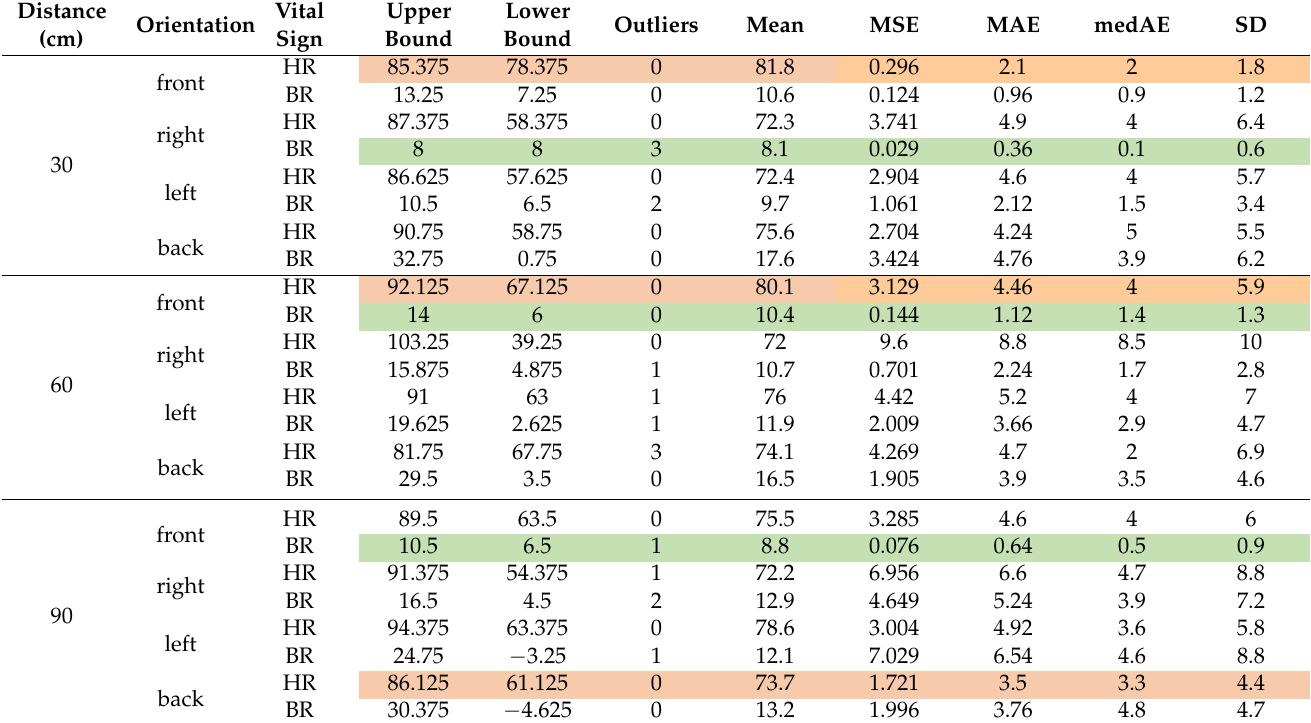
Table 4. Statistical evaluation of effect of orientation and distance on